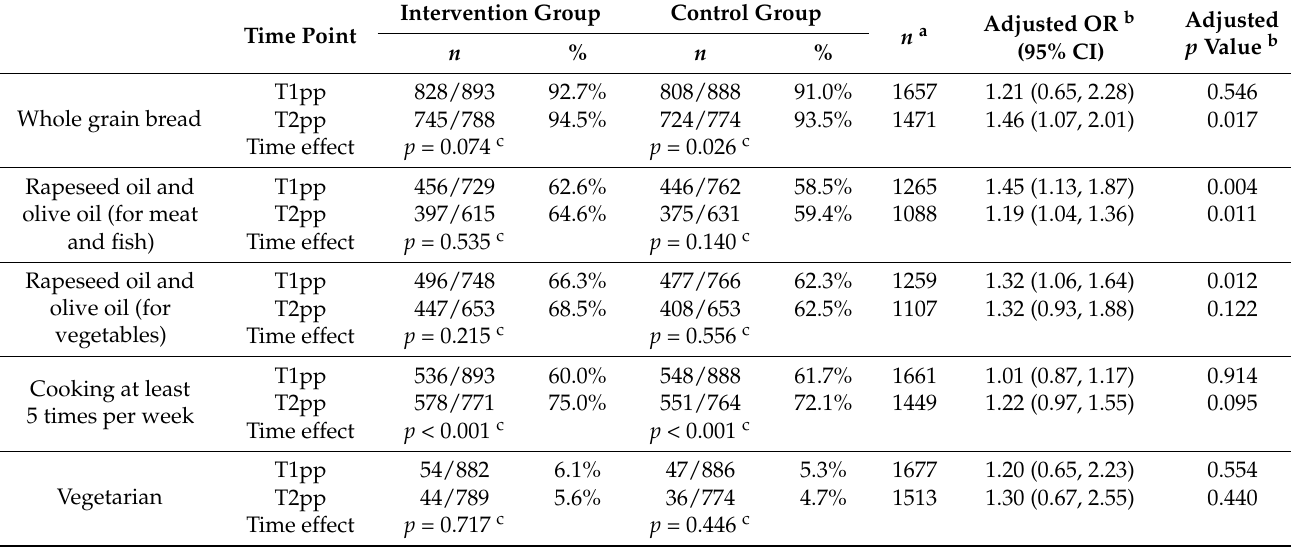
Table 3. Food preparation and dietary choices in the intervention and control groups.